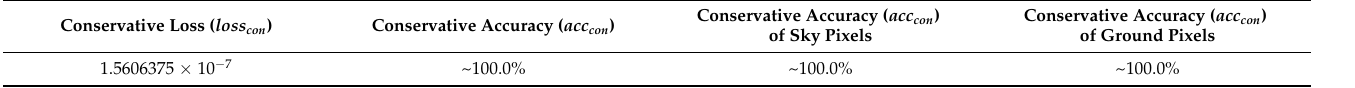
Table 3. The experimental results of the transfer learned